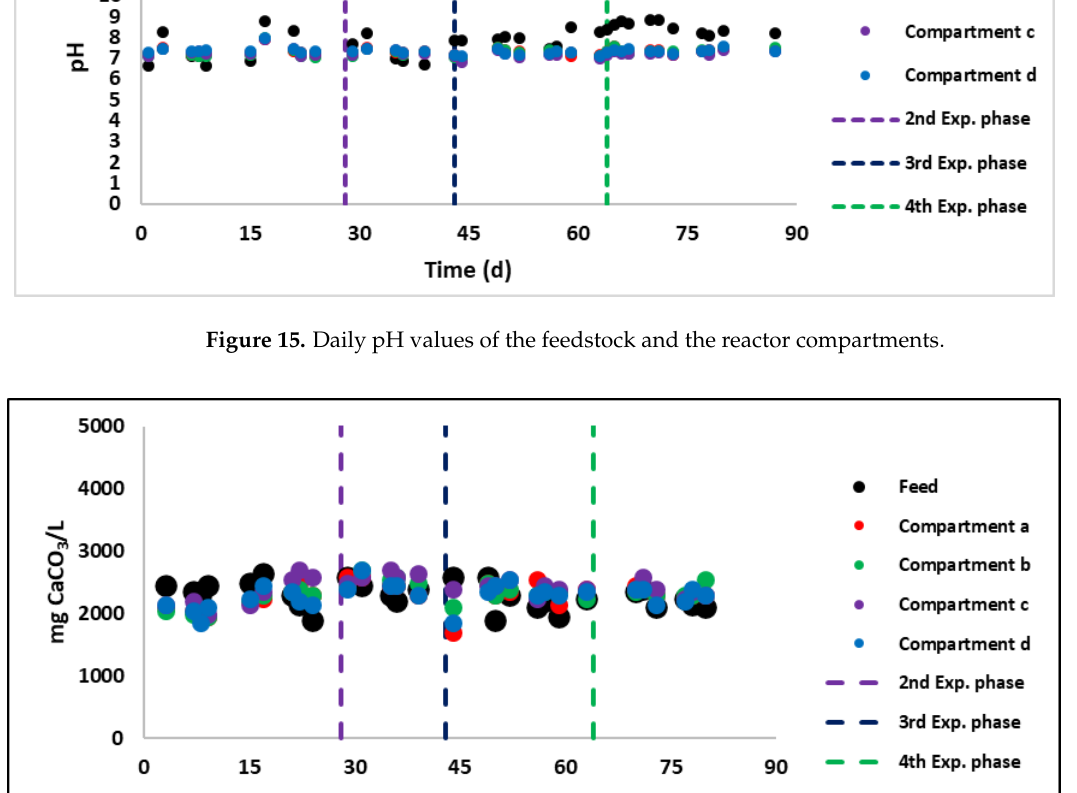
Table 7 . Average daily values of pH and total alka linity of the reactor’s feedstock, compartments and effluent.